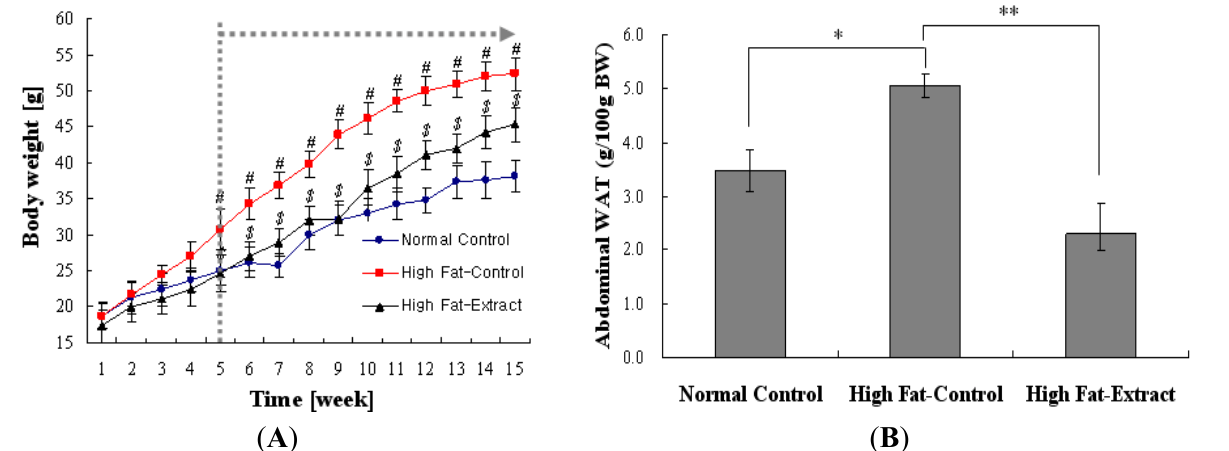
Figure 2. Effect of Buddleja officinalis Maximowicz supplementation on body weight in C57BL/6 fed high-fat diet. Values are means ± SE (n = 9 per group) #, p < 0.05 vs. normal diet. $ p < 0.05, high fat-extract vs . high-fat diet ( A ) and abdominal white adipose tissue (gWAT) in organ. Values are means ± SE (n = 9 per group) * p < 0.05 vs . normal diet; ** p < 0.001 high fat-extract vs . high fat diet ( B